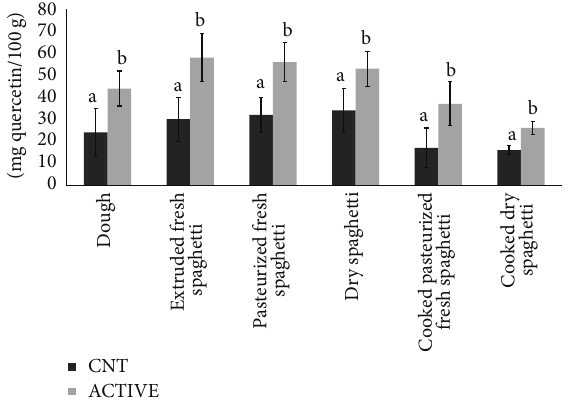
Figure 3: Total flavonoids of spaghetti samples in each step of the production process. Results are expressed as means ± SD for 𝑛 = 3 . a , b Data in columns with different superscripts are significantly different ( 𝑃 < 0.05 ). CNT: samples without the addition of grape marc extract; ACTIVE: samples with the addition of grape marc